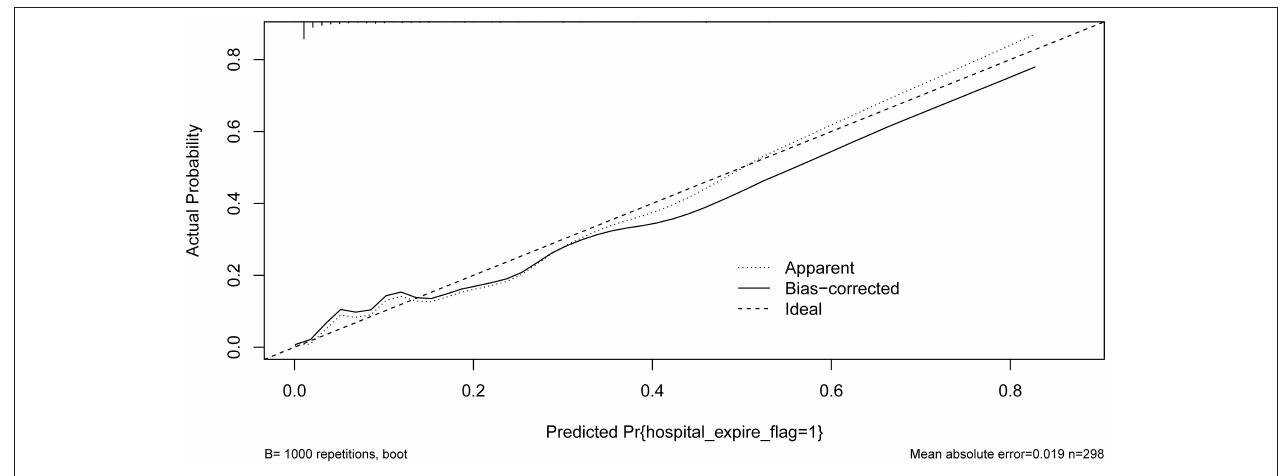
FIGURE 5 | Calibration curves of the predicted nomogram. The dashed line represents the original performance, and the solid dashed line represents the performance during internal validation by bootstrapping ( B = 1,000 repetitions). Results of the Hosmer-Lemeshow test demonstrate that the P -value was 0.648.